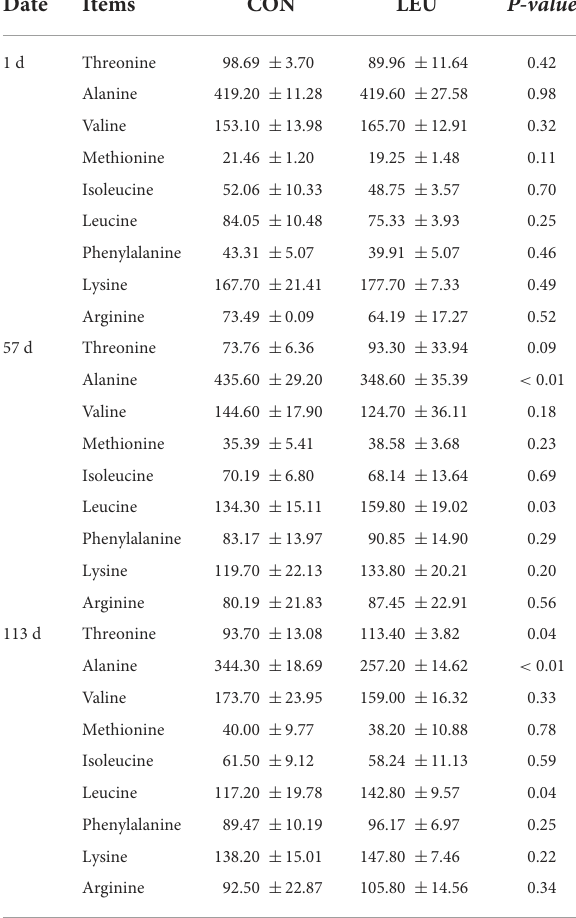
TABLE 8 Effect of dietary leucine supplementation on AA composition of testis in 150-days-old